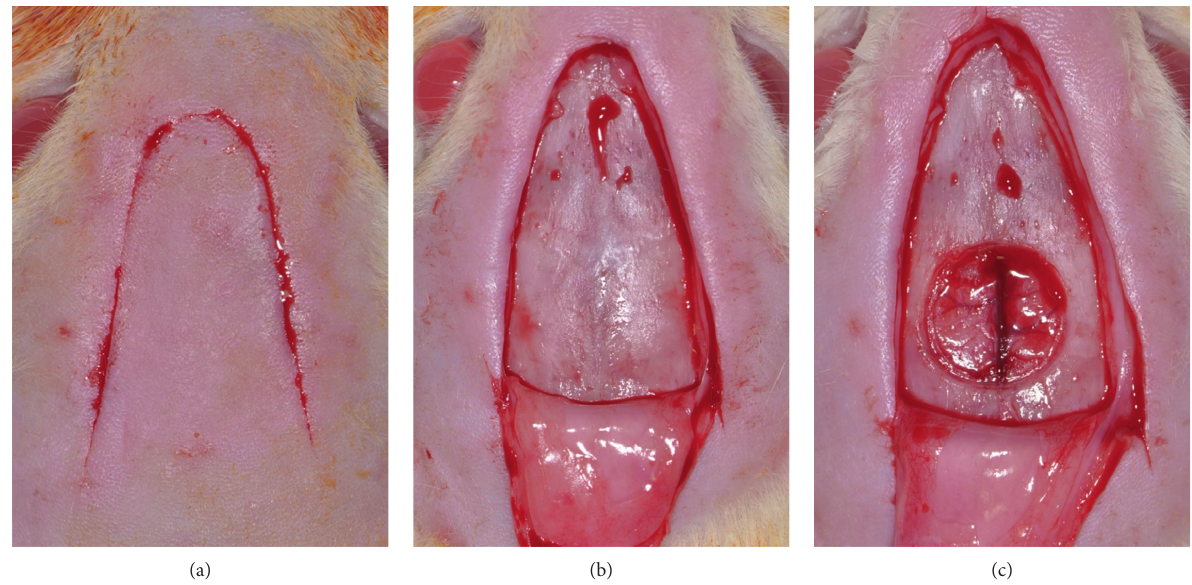
Figure 1: (a) Surgical approach. (b) Total mucoperiosteal detachment. (c) 8mm diameter bone defect, created in the center of the calvaria by the sagittal